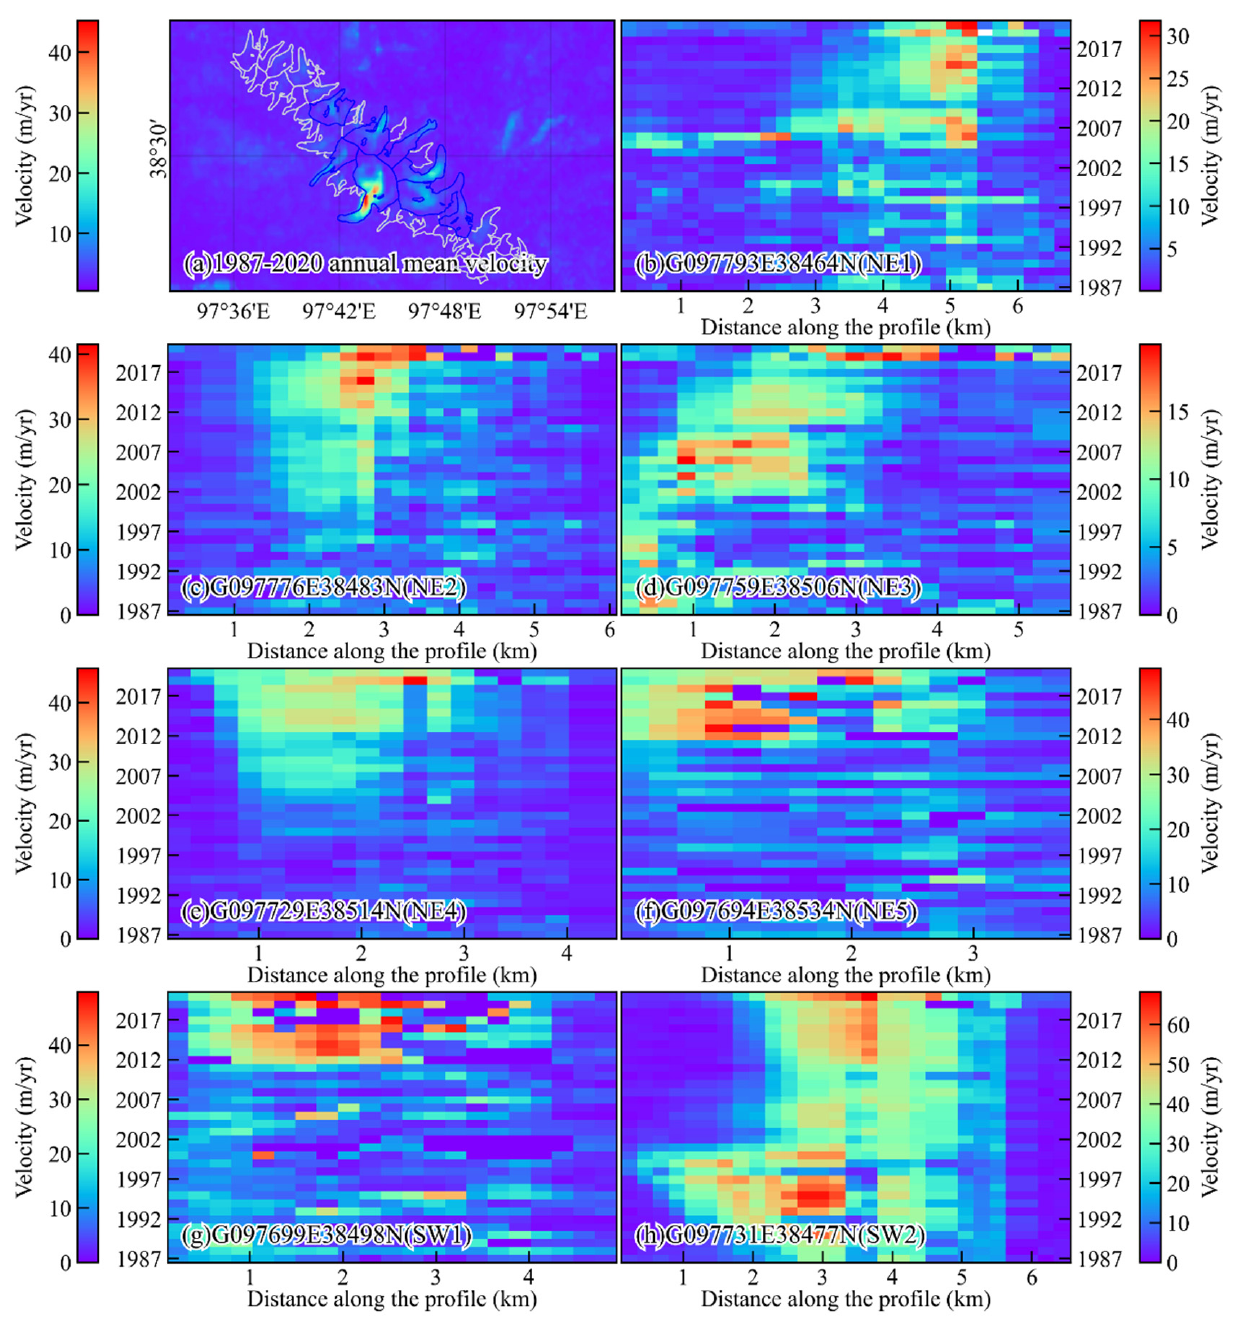
Figure 3. ( a ) The annual mean velocity of the STGs and non-STGs from 1987 to 2020 (the blue outline represents STGs); ( b – h ) centerlines annual velocity profiles for STGs in the TJP. The result was extracted from Landsat, ASTER, and Sentinel-2 images between 1986 and 2020 by COSI-CORR. Reference Figure 1 for flowline location.